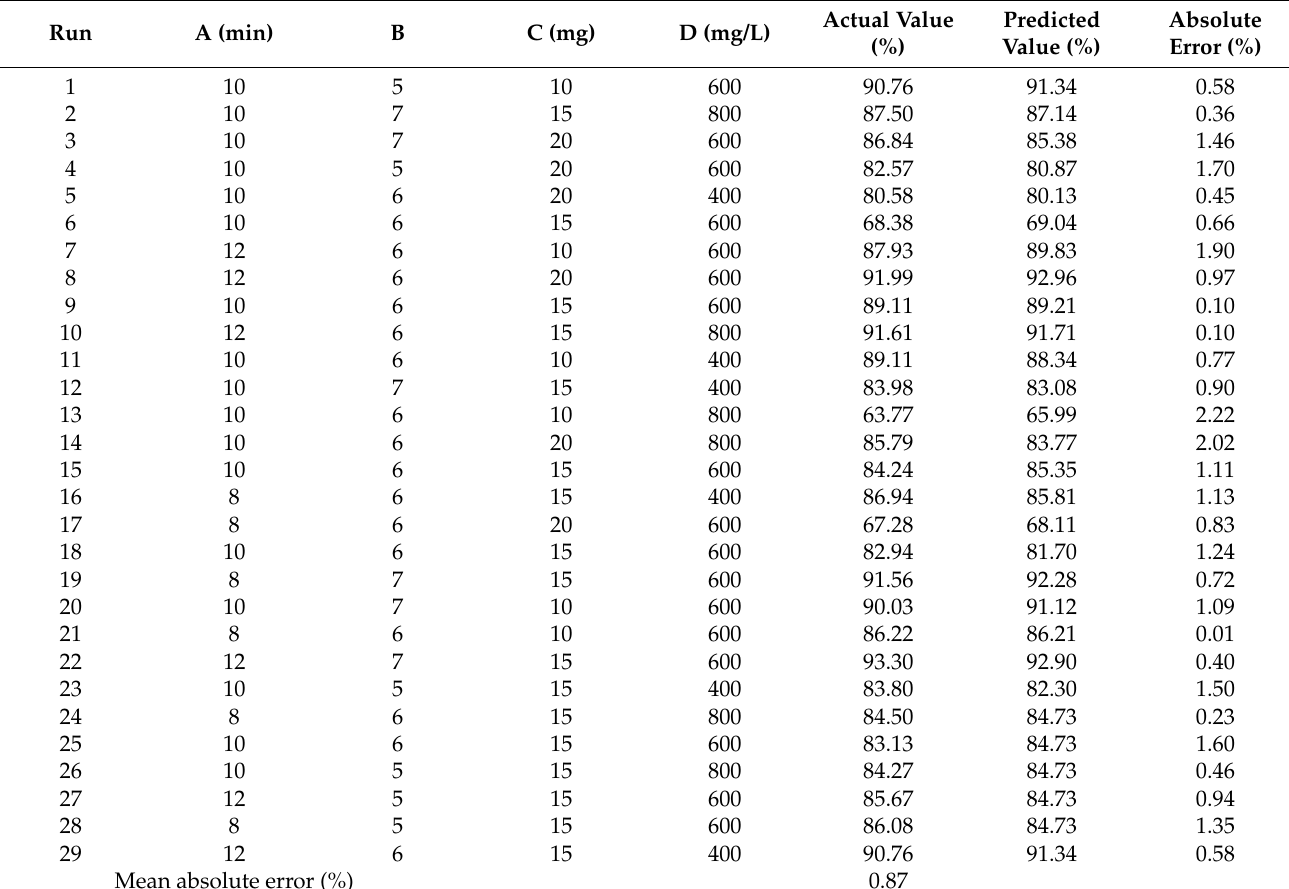
Table 3. Comparison of the decontamination efficiency predicted by the BBD model with the experimental values.